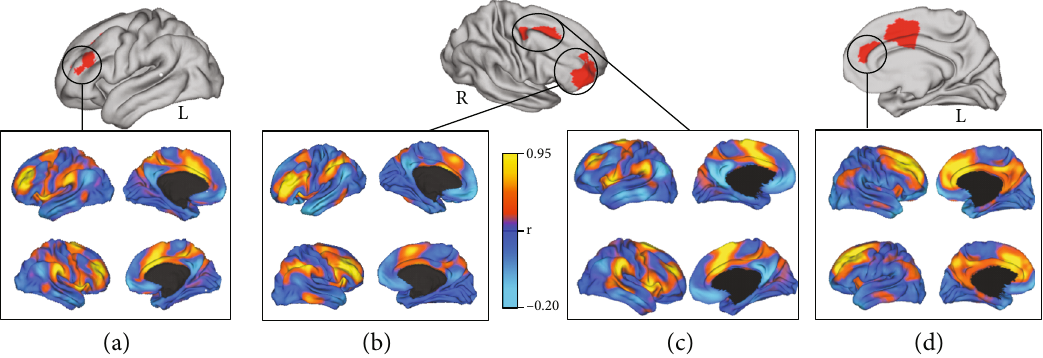
Figure 6: Network mapping of primary and secondary on-target results. (a, b) Show the network mapping of the clusters ’ peak in the prefrontal cortices. The regions correspond to the left and right dorsolateral prefrontal cortex (MNI coordinates ( x , y , z ): 34, 34, and 18; -30, 32, and 26). The mapping of the clusters ’ peak in the premotor cortex (MNI coordinates ( x , y , z ): 14, 6, and 64) and ACC (MNI coordinates ( x , y , z ): -20, 22, and 34) are reported in (c) and (d), respectively. R: right; L: left.